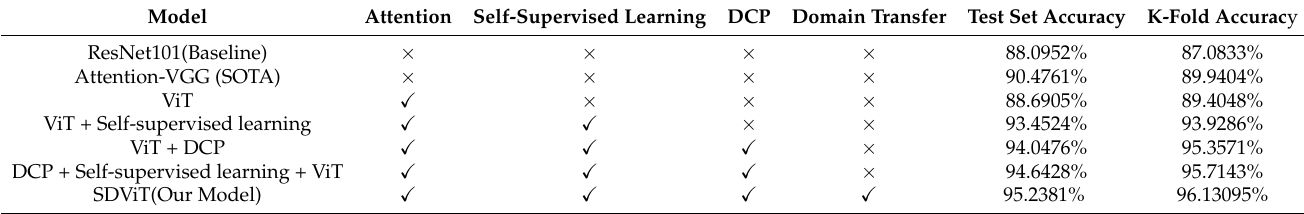
Table 6. Accuracy of different model configurations on X-ray Image dataset. Model